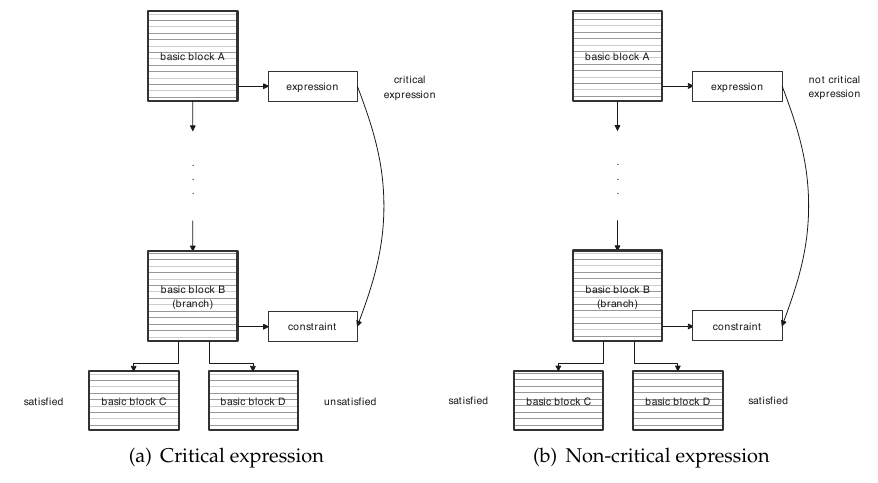
Figure 2. Identify critical